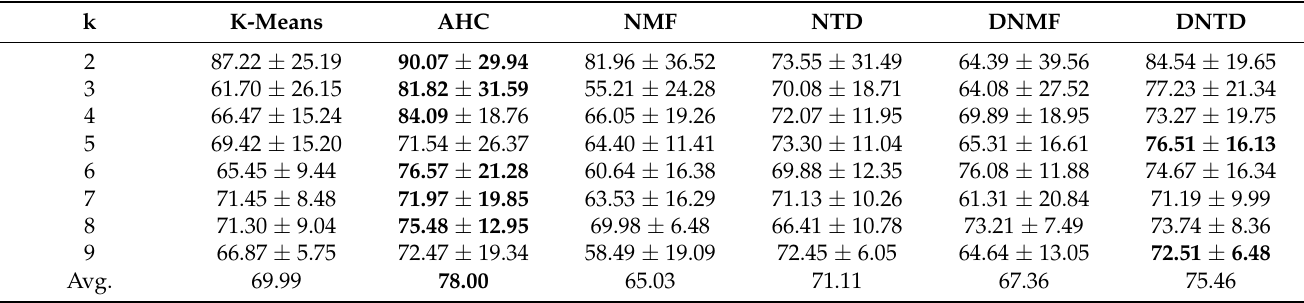
Table 4. NMI (%) ± standard deviation (%) of different algorithms on COIL20